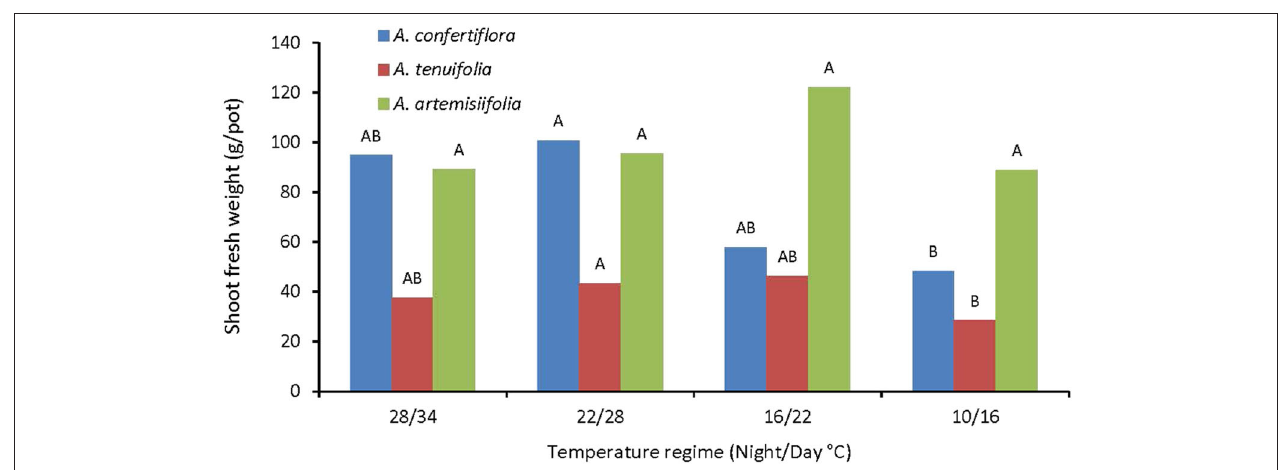
FIGURE 6 | The effect of temperature regimes on the shoot fresh weight of A. confertiflora , A. tenuifolia, and A . artemisiifolia 121 DAS. Within a species (color), columns topped by different letters are significantly different according to Tukey Kramer HSD, p = 0.001.